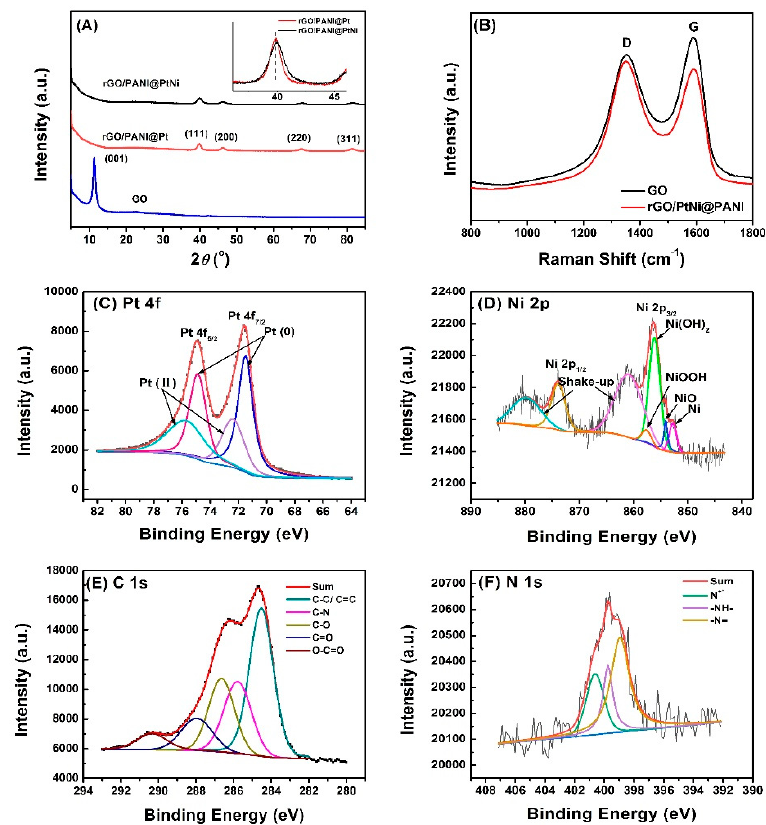
Figure 5. XRD patterns of the as-synthesized GO, rGO/PANI@PtNi, and rGO/PANI@Pt. Inset: the amplified plots of (111) peaks for rGO/PANI@PtNi and rGO/PANI@Pt ( A ); Raman spectroscopy of GO and rGO/PtNi@PANI nanocomposite ( B ); X-ray photoelectron spectroscopy (XPS) of Pt 4f ( C ), Ni 2p ( D ), C 1s ( E ), and N 1s ( F ) for the rGO/PANI@PtNi composite.